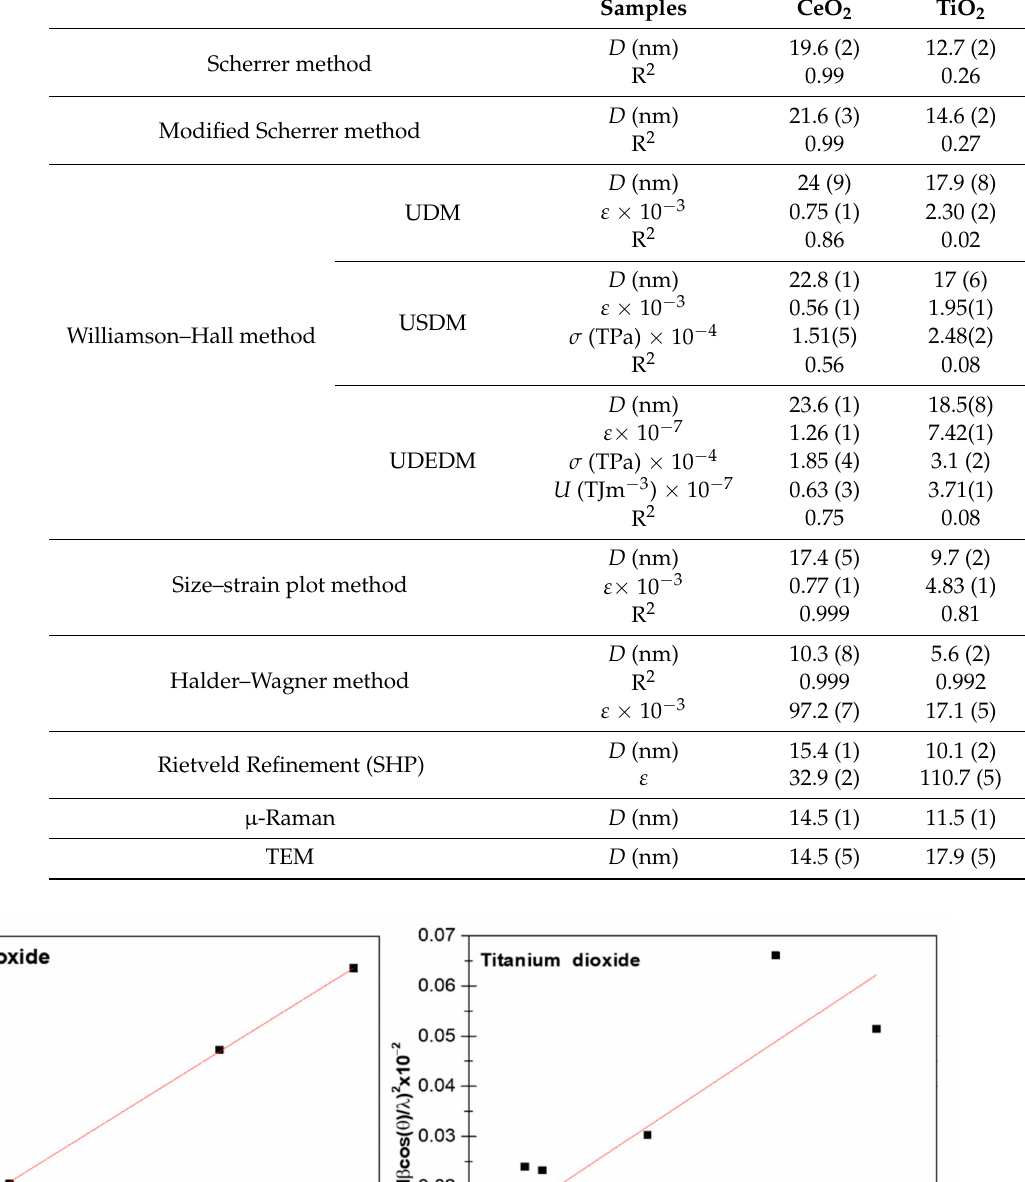
Table 1. Microstructural parameters of the CeO 2 and TiO 2 NPs obtained by several crystalline size analysis methods.